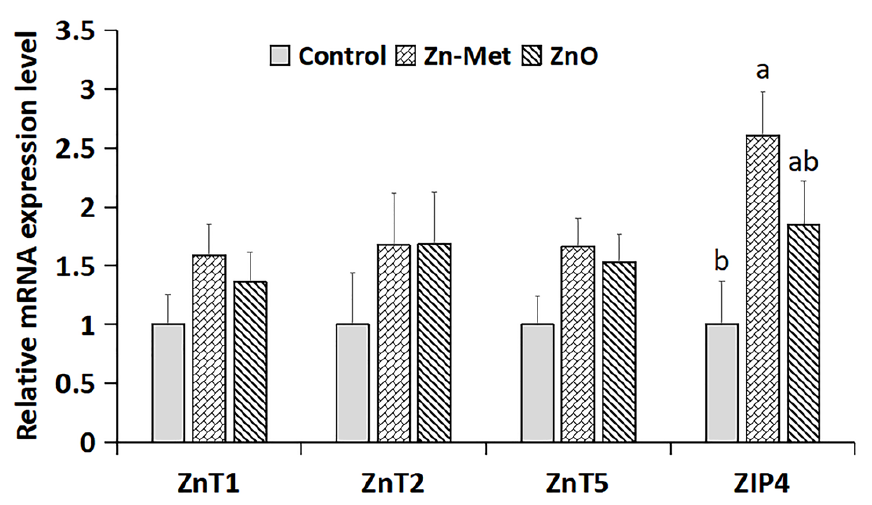
Figure 1. The mRNA expression of zinc transporters (ZnT1, ZnT2, ZnT5, and ZIP4) in the jejunum of